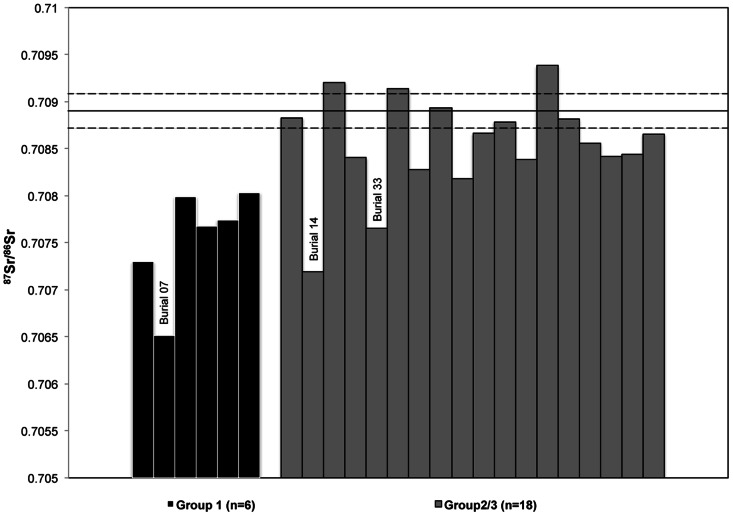
Human 87Sr/86Sr ratios compared to mean dog 87Sr/86Sr ratio (solid line) ±2 SD (dotted lines).